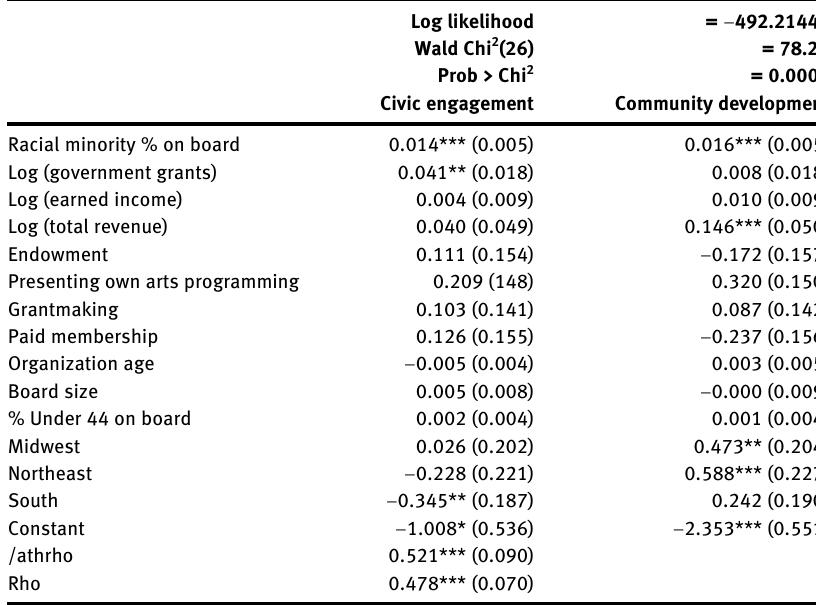
Table  : Bivariate probit regression results ( N = 